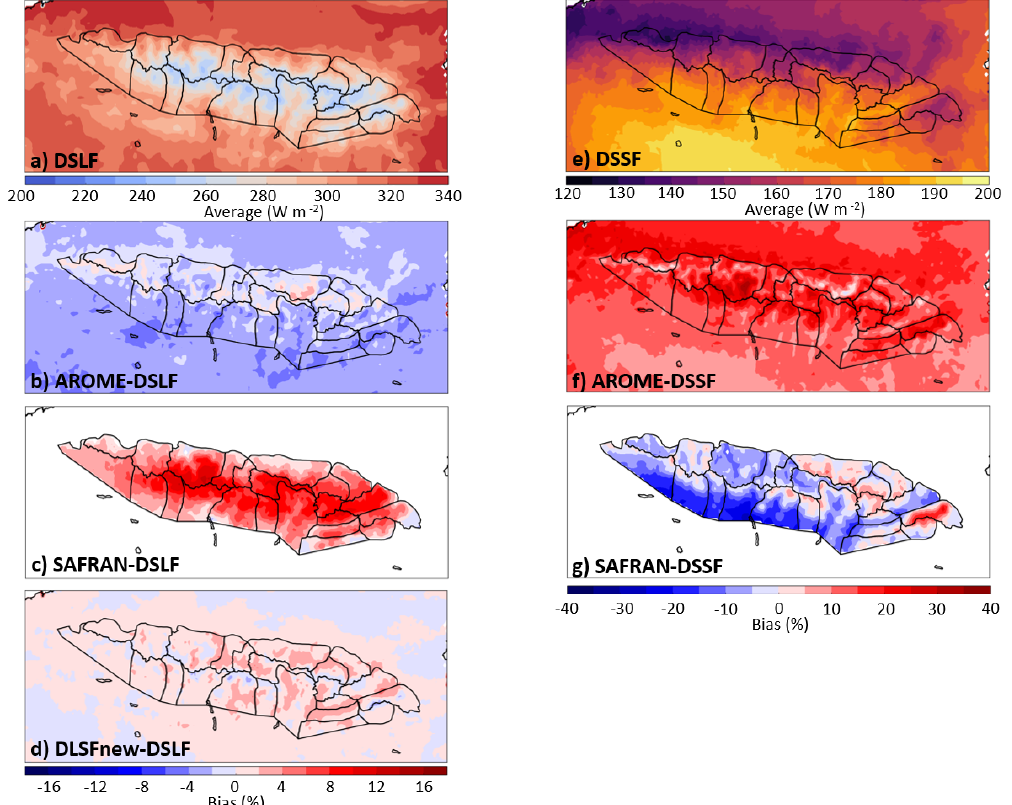
Figure 6. (a) Average of the DSLF from 1 August 2010 to 31 July 2014 in the Pyrenees, and relative difference with the DSLF for (b) AROME, (c) SAFRAN and (d) DSLFnew. (e) Average of the DSSF, and relative difference with the DSSF for (f) AROME and (g) SAFRAN.